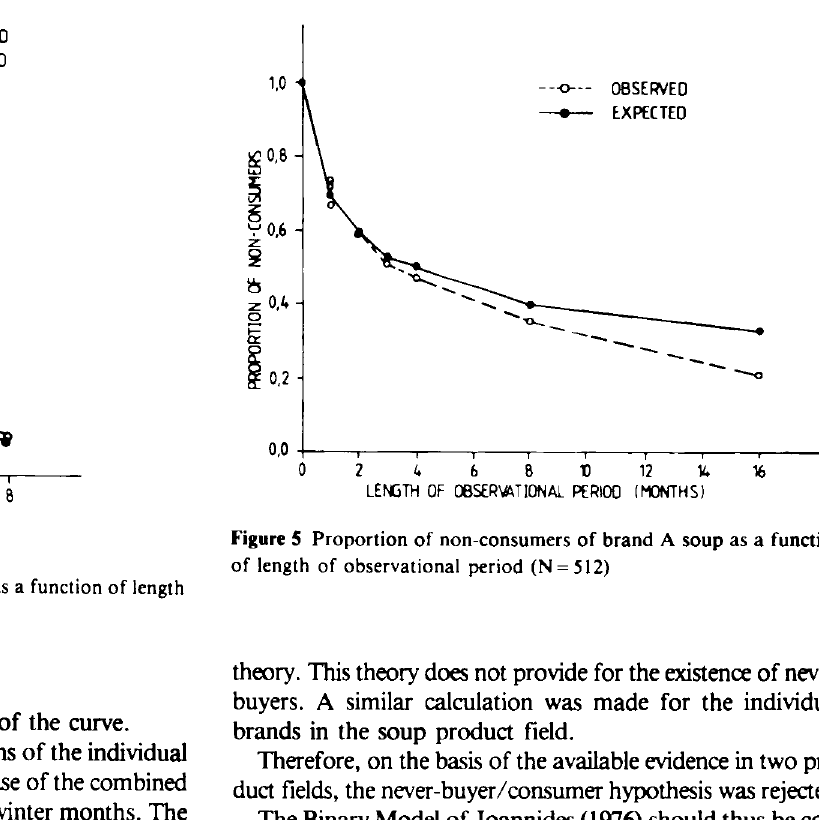
Figure 4 Proportion of non-buyers of Lux soap as a function of length of observational period (N = 614)